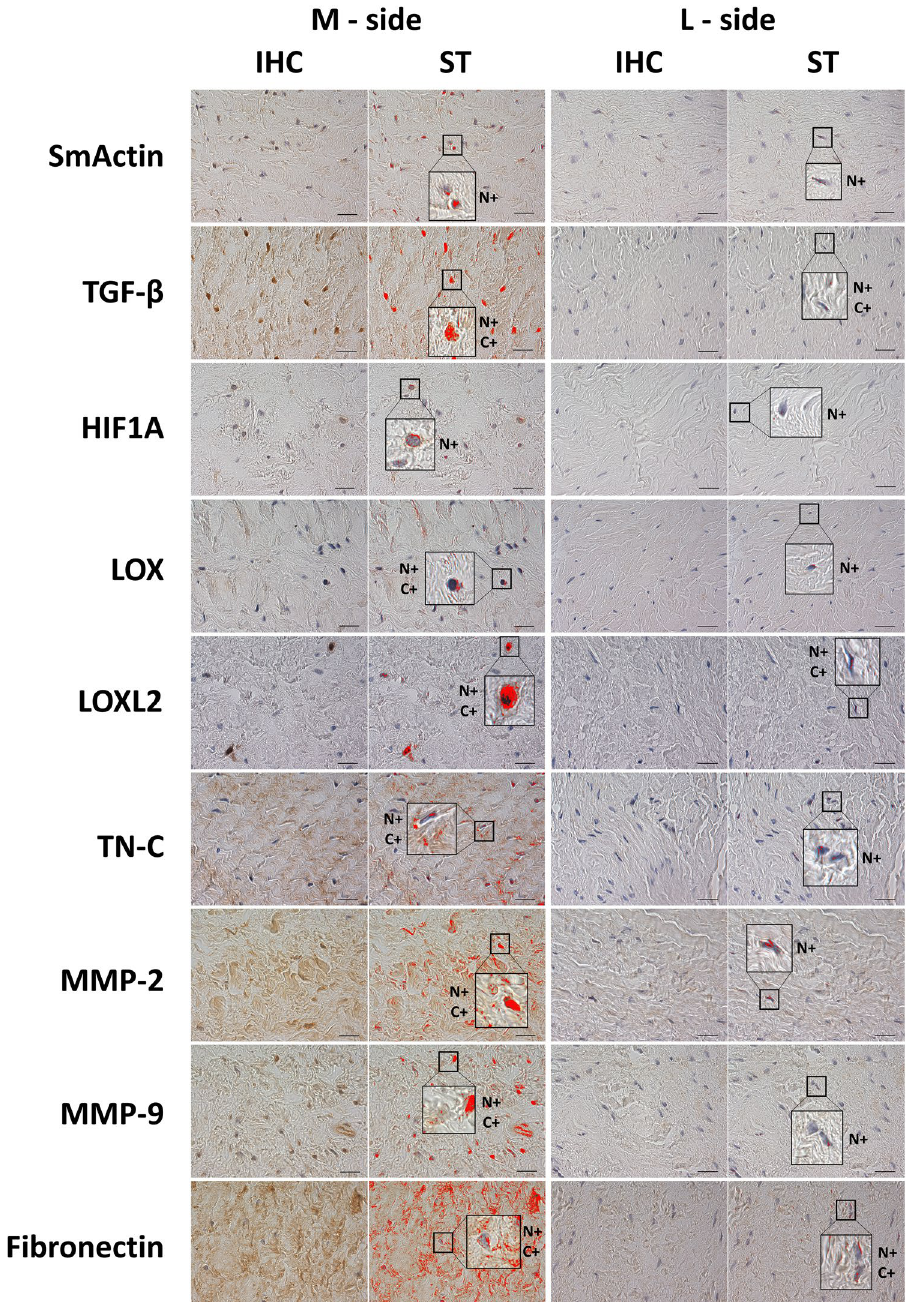
Figure 1. Demonstrative images of immunohistochemical staining and signal detection after the signal thresholding. Used antibodies: Anti-SmActin, Anti-TGF-β, Anti-HIF1A, Anti-LOX, Anti-LOXL2, Anti-TN-C, Anti-MMP-2, Anti-MMP-9, Anti-Fibronectin. The red areas in the ST columns represent the pixels analyzed after the thresholds were set. After applying the threshold settings, an image analyzer was used to measure the percentage of the area with a positive signal from the total area. IHC Immunohistochemistry, ST Signal Threshold, N+ Nuclear positivity, C+ Cytosolic positivity. Scale bar = 20